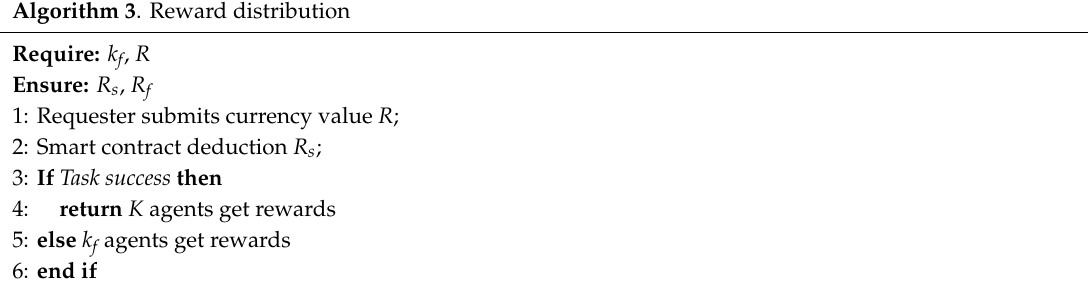
Algorithm 3 . Reward